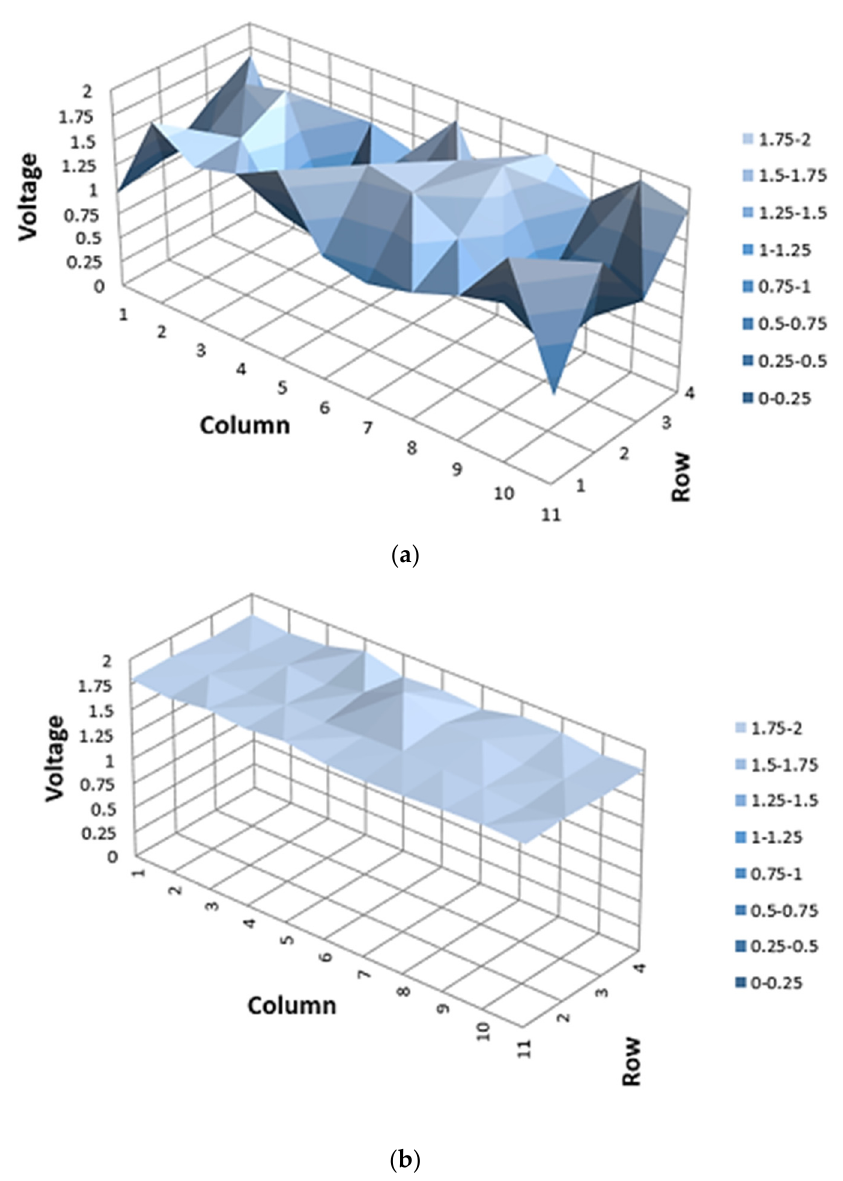
Figure 8. 3D graph of before ( a ) and after ( b ) applying proposed adjustment technique to the entire array.